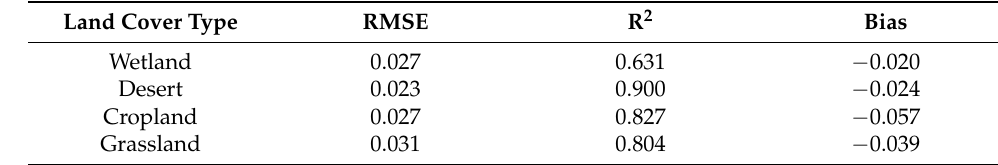
Figure 3. Comparisons of GF-1 WFV albedo and surface results in the experimental area of ( a ) wetland sites, ( b ) desert sites, ( c ) cropland sites, and ( d ) grassland sites. Table 3. Accuracy verification results for various land cover types.